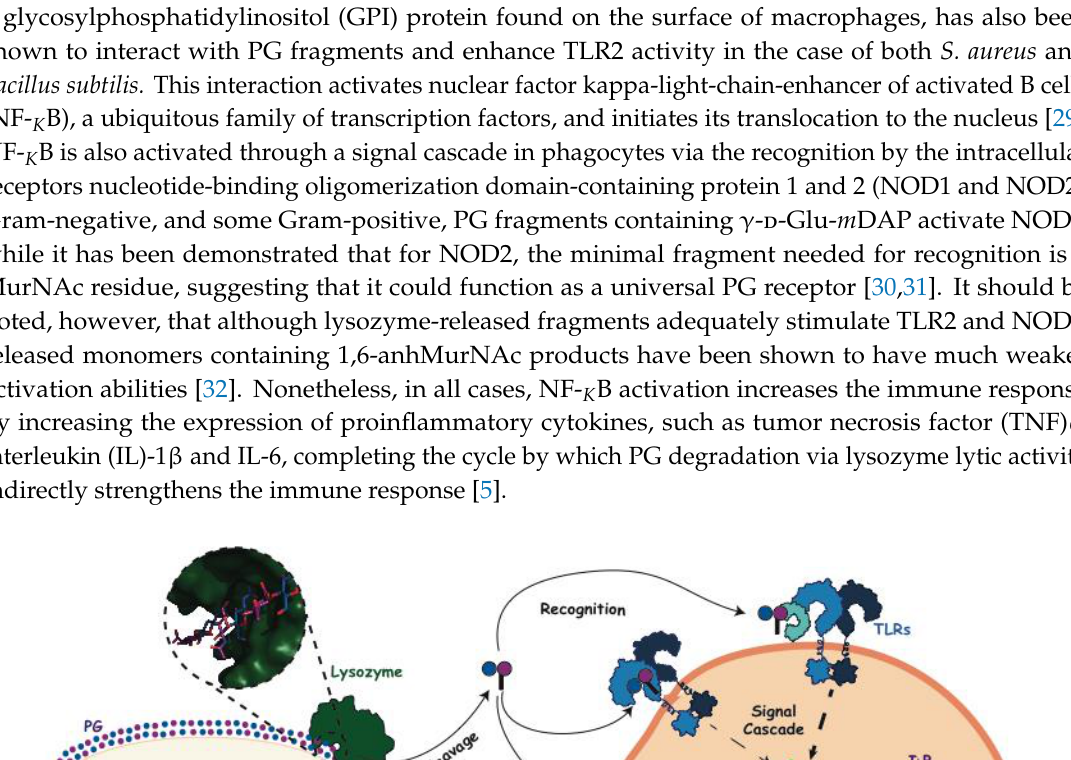
inflammatory response. Cytoplasmic NF- k B is inhibited by I k B (PDB IDs: 1NFI, 1VFI, light green and